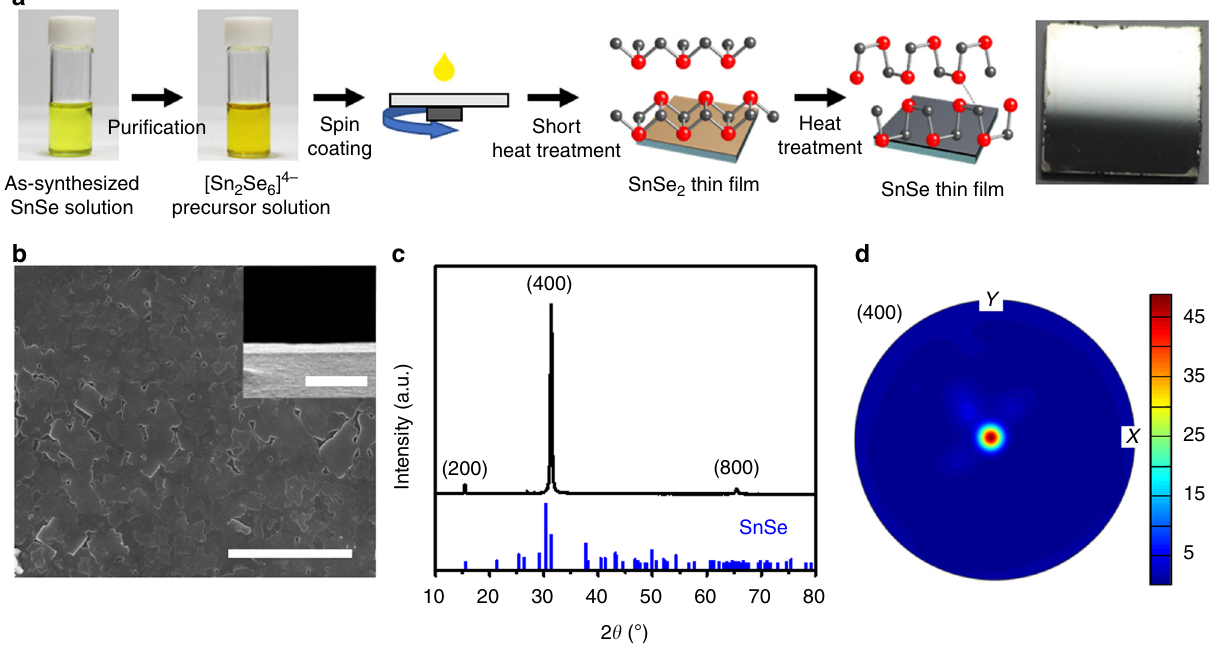
Fig. 1 Solution-processed fabrication of highly textured SnSe thin fi lms. a Schematic illustration of the fabrication process of SnSe thin fi lms. SnSe ink solution was synthesized by a two-step process, which involves dissolving SnSe powder in a solvent composed of ethylenediamine and ethanedithiol, and purifying the resulting solution with acetonitrile to obtain a precipitate. The precipitate was dissolved in ethylenediamine to obtain the SnSe ink solution. The ink was spin-coated on a glass substrate and the fi lm was heated for 1 min at 400 °C. The coating process was repeated to obtain the desired thickness. Finally, the fi lm was annealed at 400 °C for an appropriate time. The photograph shows the fabricated fi lm had a mirror-like re fl ection, indicating high uniformity. b SEM image of the SnSe thin fi lm fabricated with puri fi ed precursor solution shows full coverage of SnSe on the substrate. Scale bar, 5 μ m. Cross-sectional SEM image (inset) shows a uniform thickness of 85 nm. Scale bar, 500 nm. c XRD pattern of the SnSe thin fi lm fabricated with puri fi ed precursor solution clearly shows peaks indexed to the (200), (400), and (800) planes, indicating the highly oriented texture. Vertical lines indicate the pattern for orthorhombic SnSe reference (JCPDS 32 – 1382). d Pole fi gure of the (400) plane in the SnSe thin fi lm fabricated with puri fi ed precursor solution. Colours of the strips indicate the pole density in multiples of random distribution. High intensity at the centre clearly demonstrates the texturing in the thin fi